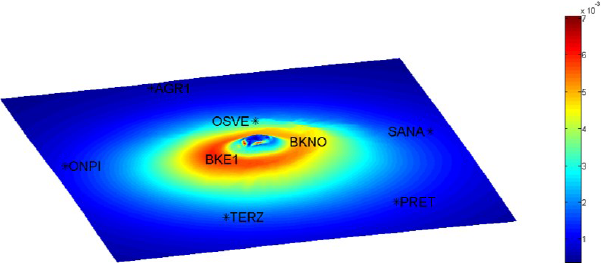
Figure 3. Map of vertical displacements produced by a source located at 2km depth embedded in homogenous medium ( E = 10GPa and σ = 0 . 3). The names and locations of continuous GNSS stations are shown.